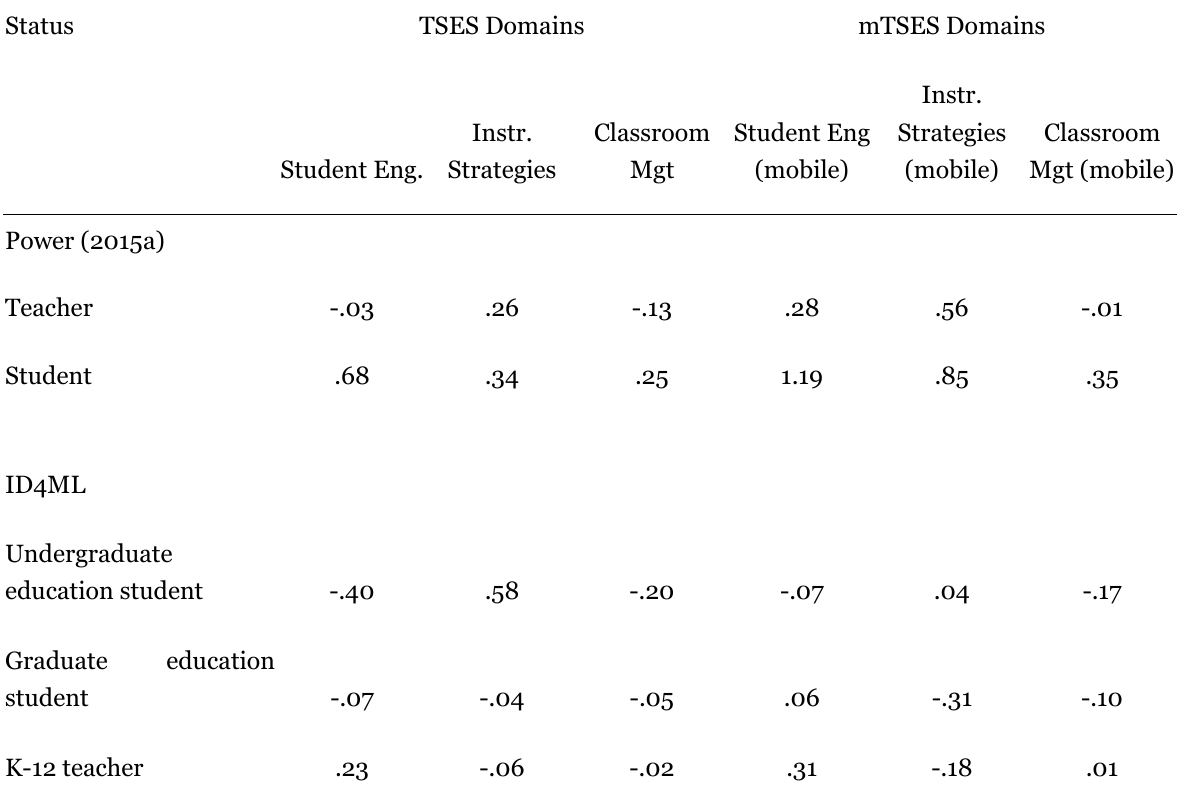
Changes in TSES and mTSES Scores by Participant Status Status TSES Domains mTSES Domains